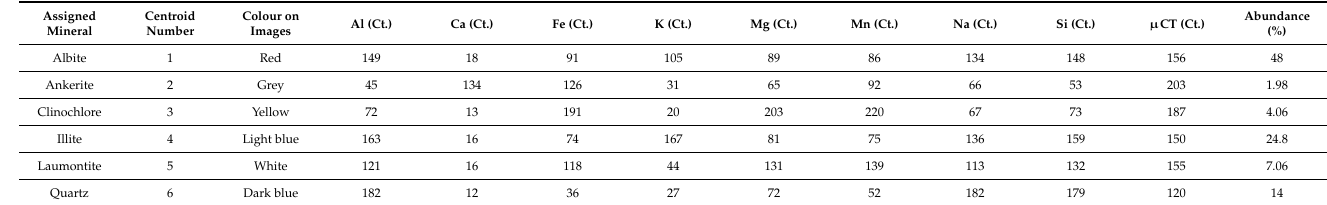
Table 2. µ XRF K-means clustering results. The clustering centroids for the µ XRF maps of the bottom surface are shown as normalised 8 bit fluorescence intensities with a minimum of 0 and maximum of 255. Additionally, the abundance percentage of the labels are shown along with the assigned mineral.